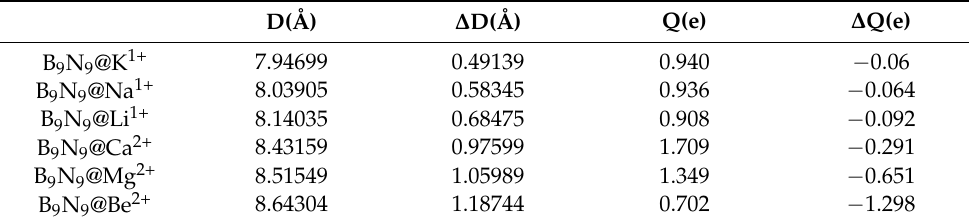
Table 4. Geometric structure and charge variation in different ionic complexes of B 9 N 9 .